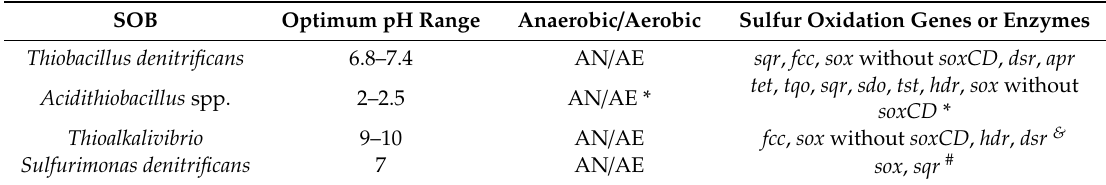
Table 2. Physiological characteristics and sulfur oxidation genes of some selected chemolithotrophic sulfur-oxidizing bacteria (SOBs). Adapted from